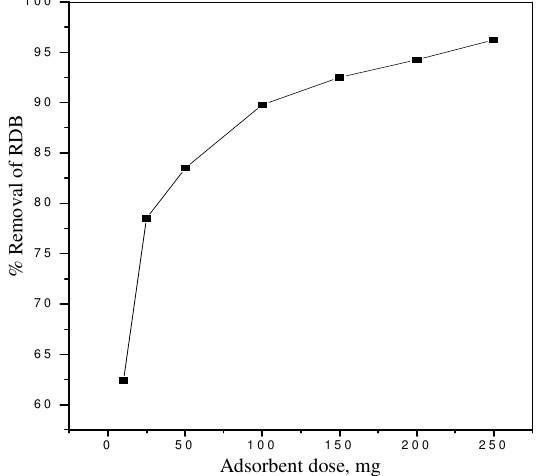
Figure 1 . Effect of adsorbent dose on the removal of RDB